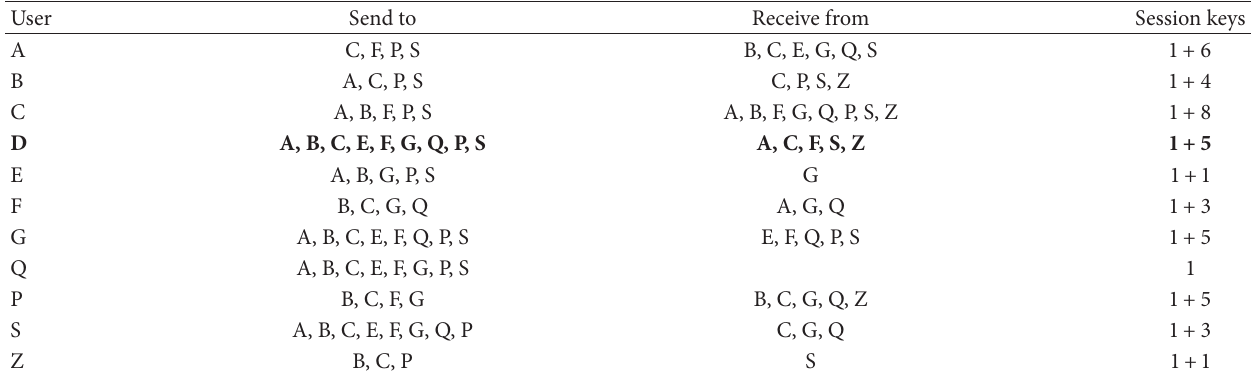
Table 6: Send to/receive from list and keys information after a node leaves the network.